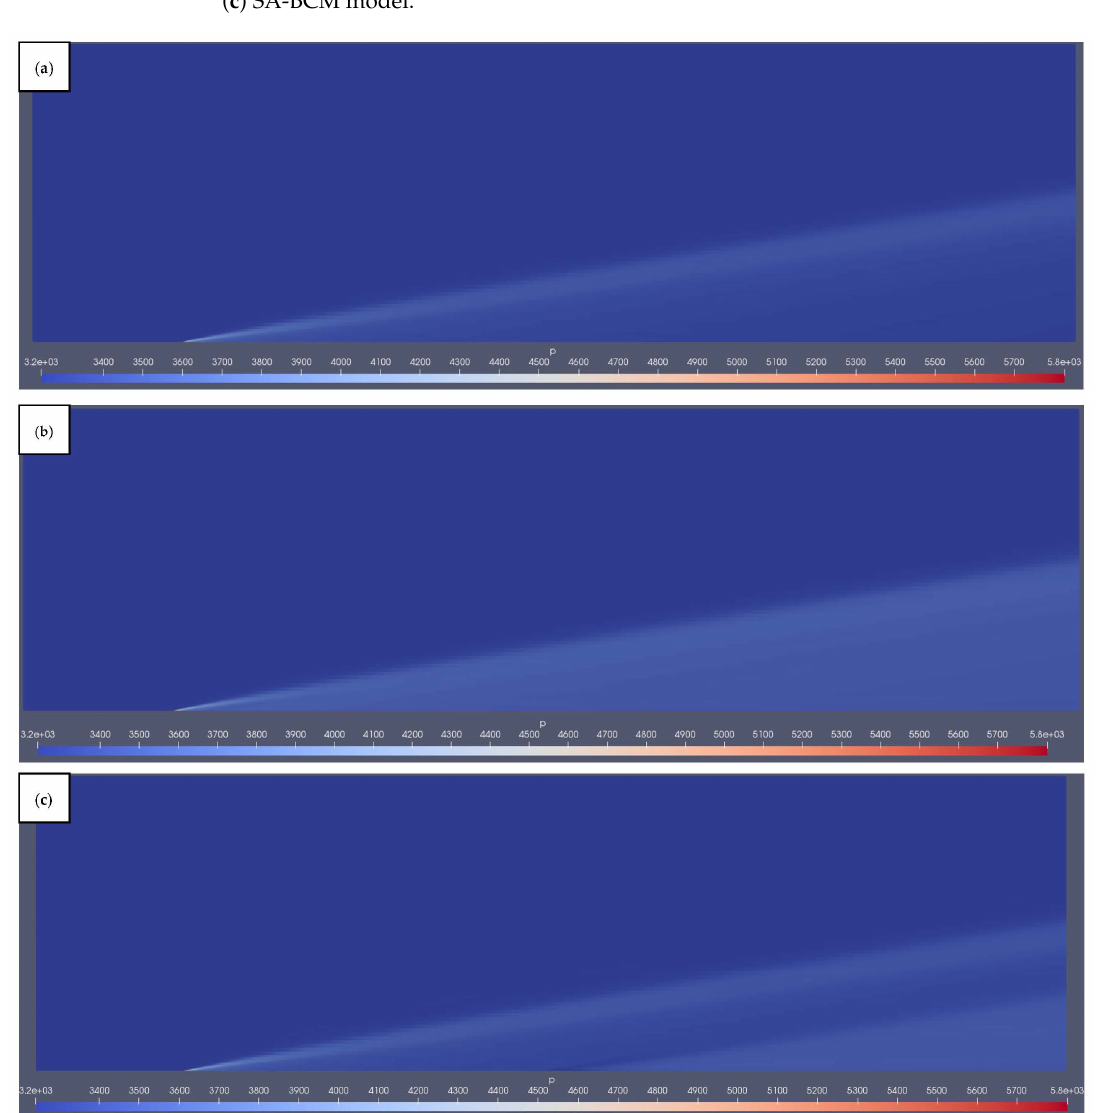
Figure A6. Pressure profile of s00: ( a ) laminar model; ( b ) SA model; ( c ) SA-BCM model.